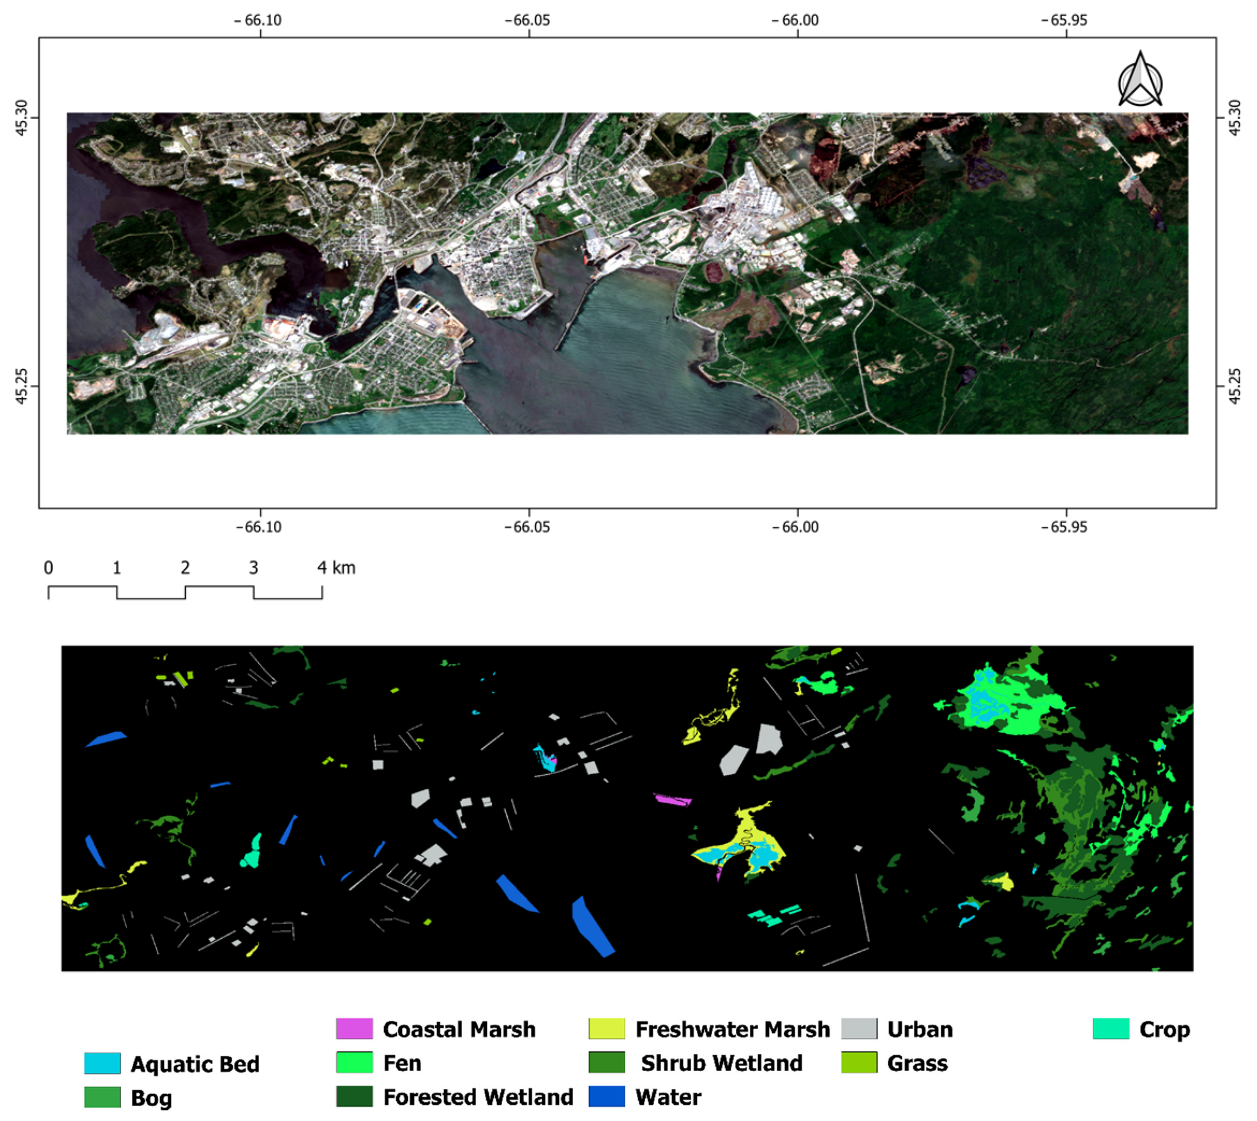
Figure 3. Sentinel-2 true color of the study area of Saint John city located in New Brunswick, Canada, and spatial distribution of ground truth data in the pilot site.